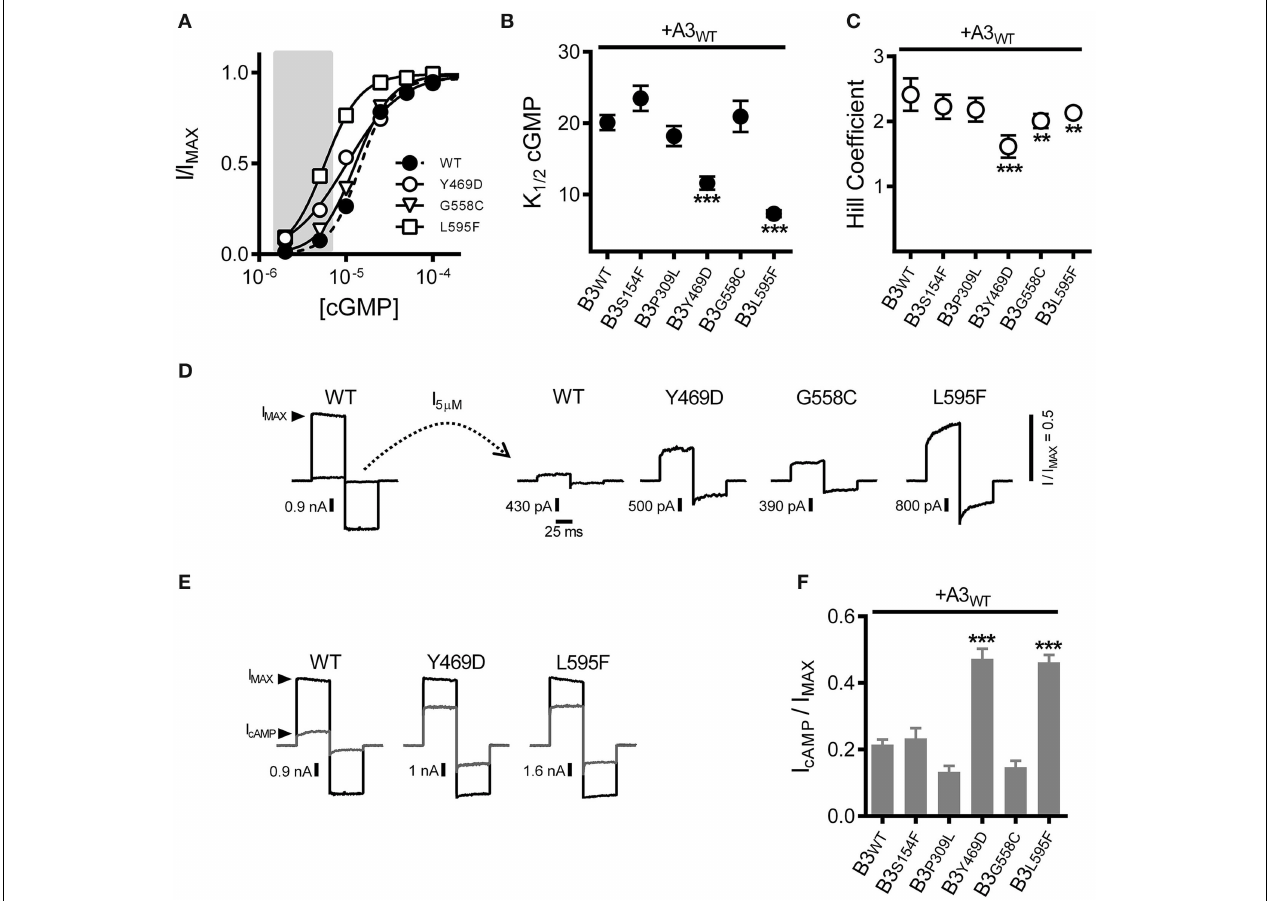
FIGURE 2 | Macular degeneration-associated Y469D and L595F mutations in CNGB3 each increase the sensitivity of heteromeric A3 + B3 channels to physiological ligands. (A) Representative dose-response curves for activation of A3 + B3 wild type (WT; filled circles), A3 + B3 Y469D (Y469D; open circles), A3 + B3 G558C (G558C; open triangles), and A3 + B3 L595F (L595F; open squares) channels by cGMP.